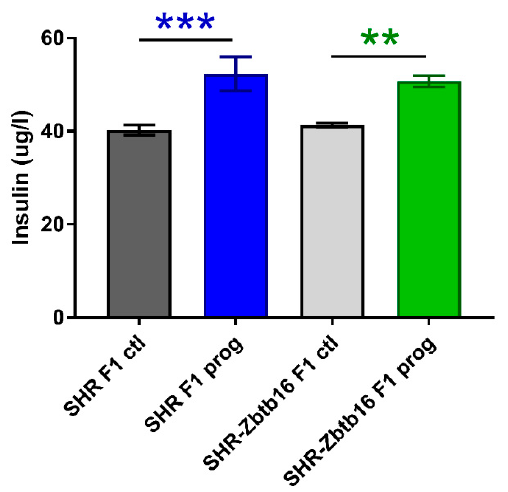
Figure 4. Fasting insulin concentrations in SHR F1 control females (dark grey bars), SHR-Zbtb16 F1 control females (light grey bars), F1-programmed SHR females (blue bars), F1-programmed SHR-Zbtb16 females (green bars) in adulthood. The strain comparison using the post-hoc Fisher’s least significant difference test of the two-way ANOVA for STRAIN and PROGRAM as major factors are indicated as follows: ** p < 0.01, *** p < 0.001. Effect of programming in SHR and SHR-Zbtb16 strains is represented by blue and green asterisks (*), respectively.